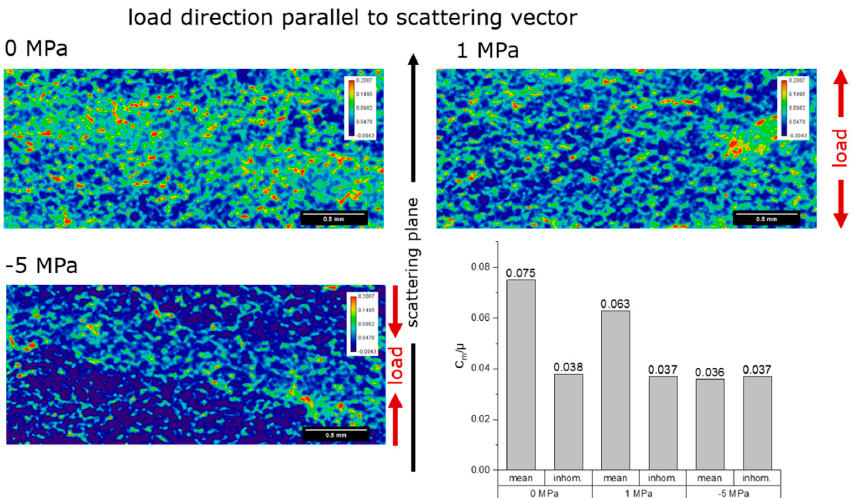
Figure 8. Visualization of the local values of the relative specific refraction value C m / µ of the specimen as 2D color-coded images for the orientation of the load direction of the specimen parallel to the scattering plane of the analyzer crystal. The load direction was parallel to the scattering vector. Top left: Unloaded, top right: 1 MPa tensile loaded and bottom left: 5 MPa compression loaded. Bottom right: The integral values of the relative specific surface for all specimens are shown as bar graphs. The small bars represent the inhomogeneity of the µ ∙ d values across the measured area of the specimen.